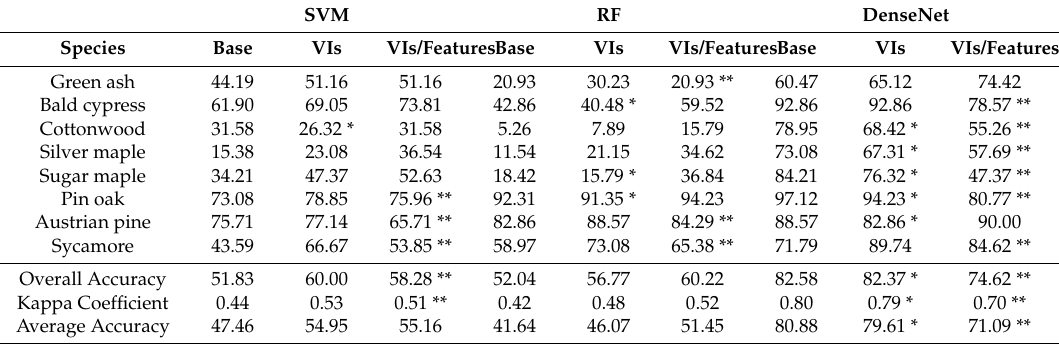
Table 7. Classification accuracies for eight dominant tree species incorporating 13 VIs and 118 extracted